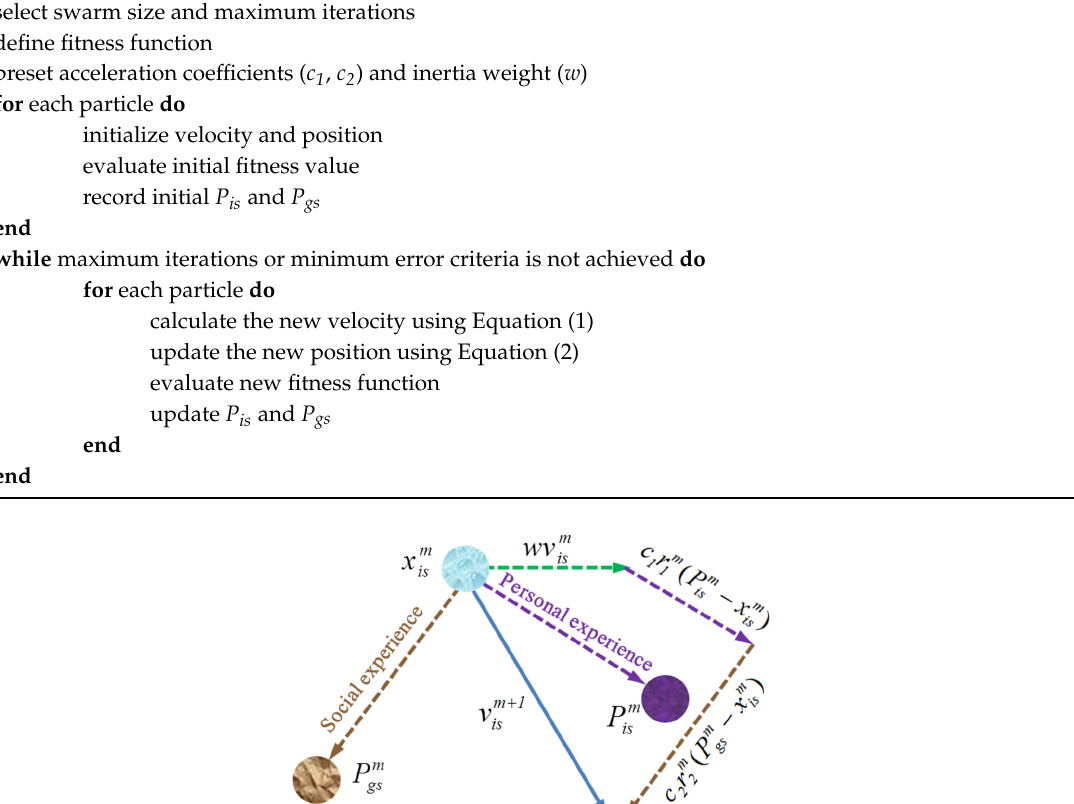
Algorithm 1. Conventional Particle Swarm Optimization for TSP select swarm size and maximum iterations